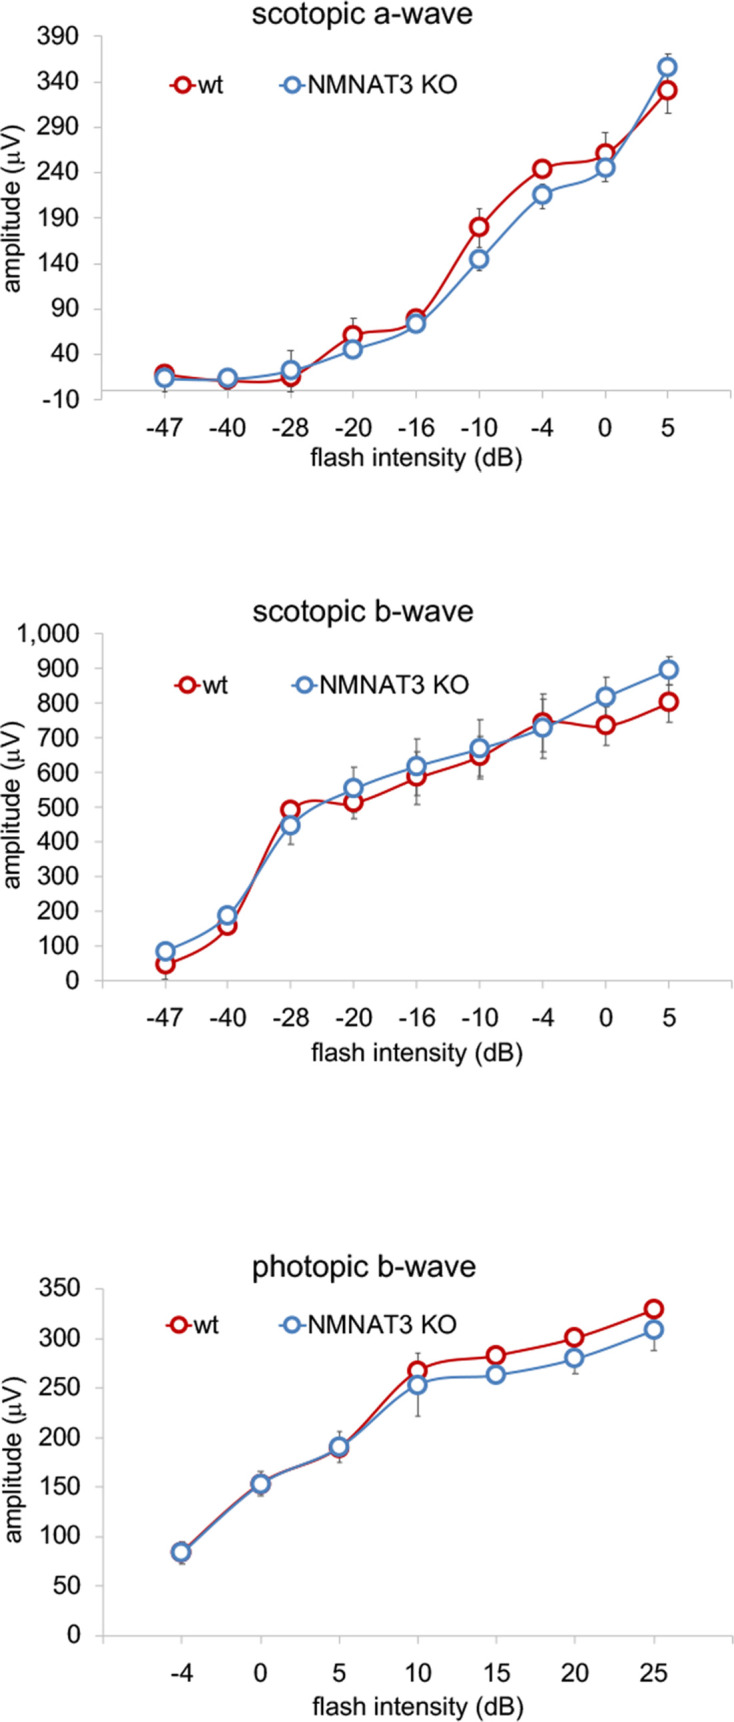
ERG analysis of NMNAT3-deficient retina.ERG analysis of WT or NMNAT3 knock out mice (NMNAT3 KO). Graphs show the average and error bars represent the standard error. Statistical analysis was performed by one-way ANOVA (n = 3 mice for WT, n = 3 mice for NMNAT3 KO). F (8, 36)=0.78, p=0.623 for scotopic a-wave, F (8, 36)=0.28, p=0.97 for scotopic b-wave, F (6, 28)=0.23, p=0.97 for photopic b-wave and there is no statistical difference between WT and NMNAT3 KO in each flush intensity.Figure 2—figure supplement 1—source data 1.Source data for Figure 2—figure supplement 1.